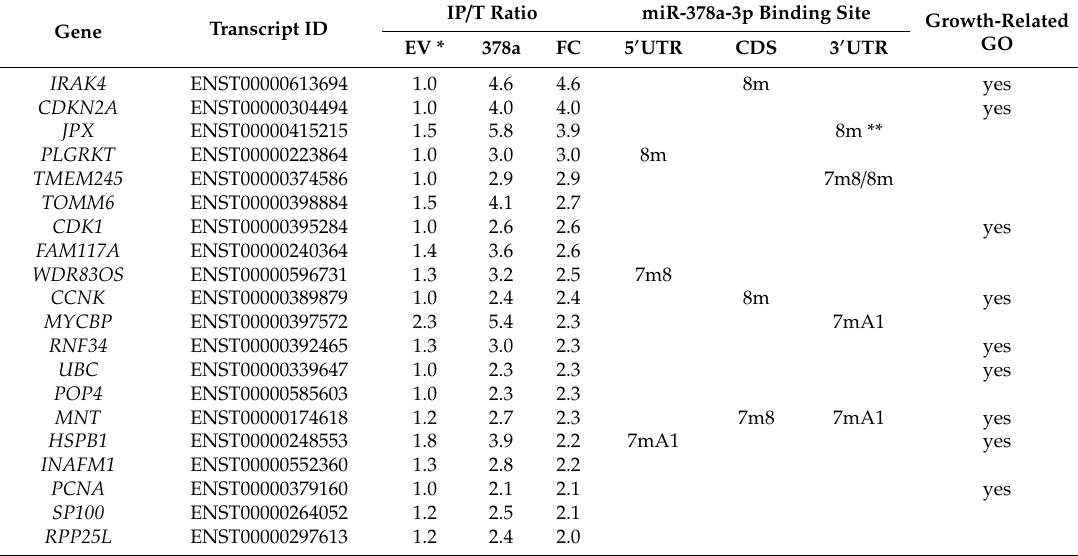
Table 2. Identified targets of miR-378a-3p upon overexpression.